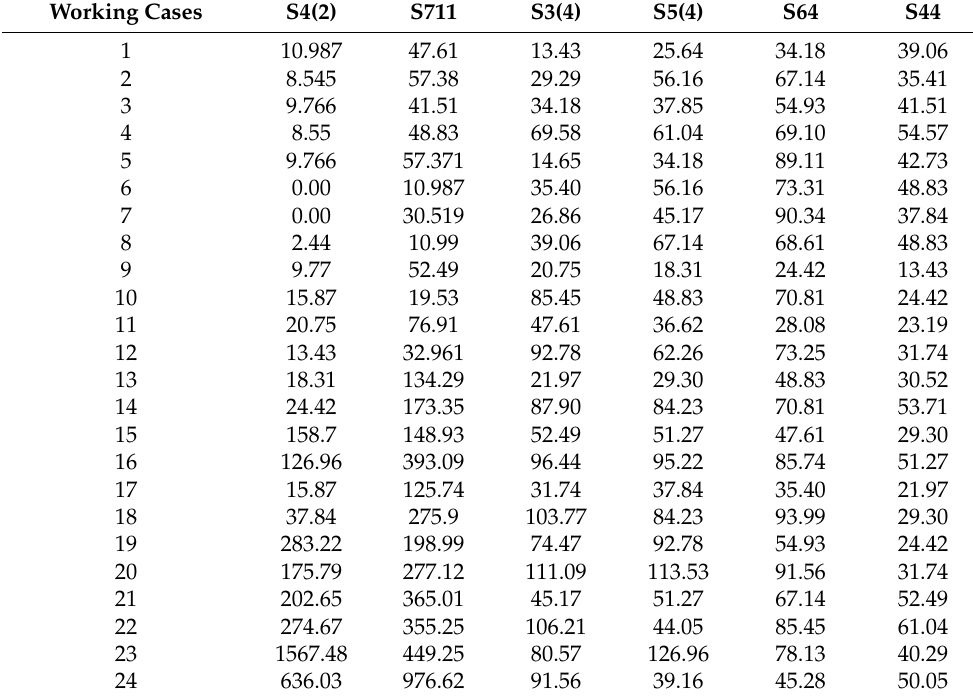
Figure 5. The flowchart of wavelet decomposition for vibration and rupturing superposition signals collected by AE sensors. Table 4. Increment strains at vault and